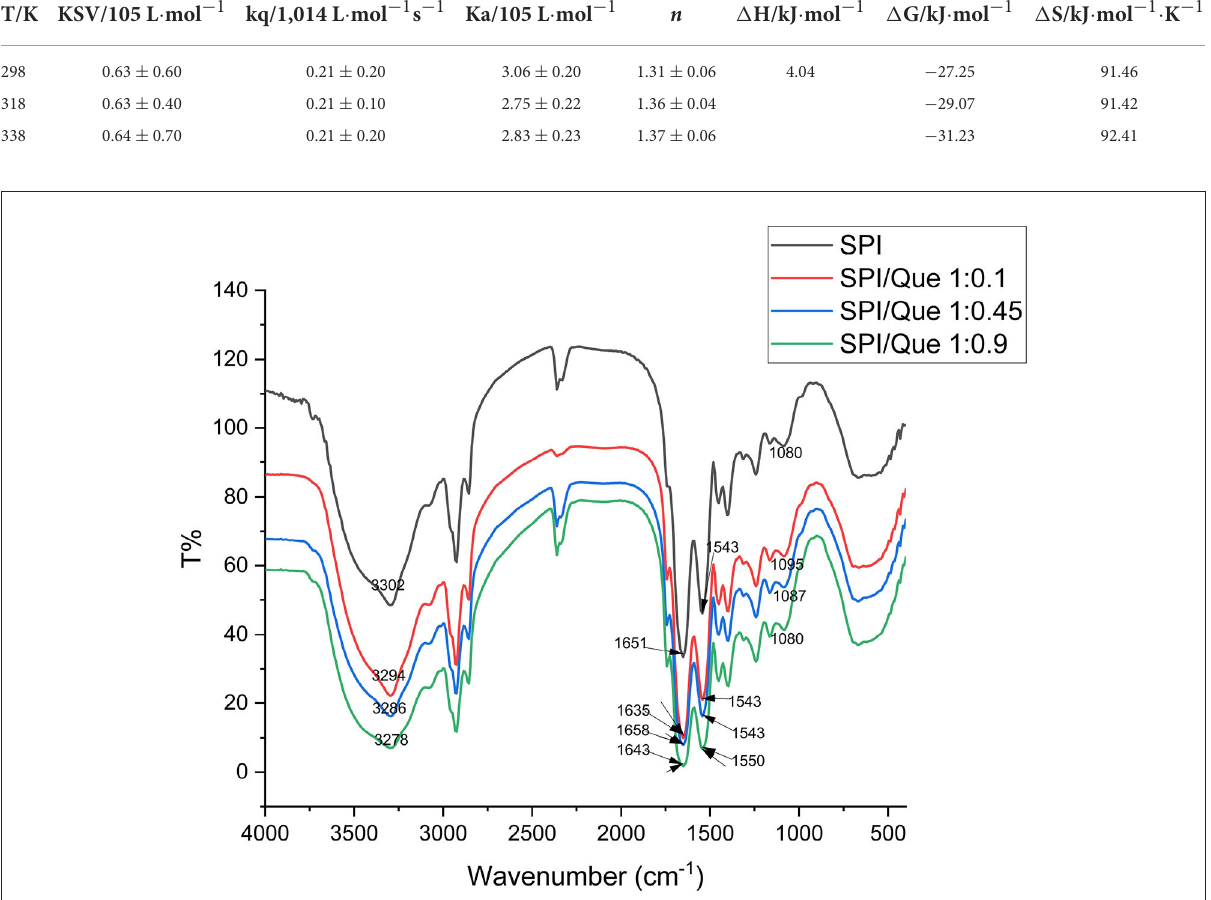
FIGURE3 Fourier transform infrared spectra of SPI and SPI-quercetin complexes with different molar ratio (1:0.1, 1:0.45, 1:0.9) at 298K. The corresponding wavelength of the characteristic peaks were marked in this